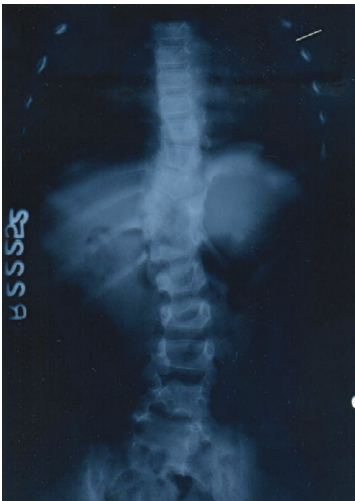
Figure 2: X-ray of the chest region and abdomen showing absence of lower ribs on the left side and scoliosis.